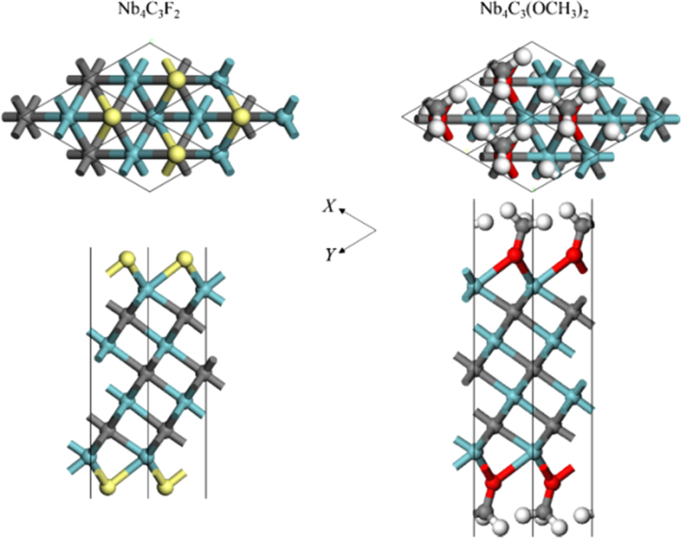
Top views and side views from the X direction of the optimal structures of Nb4C3F2 and Nb4C3(OCH3)2. The atoms represented by different color balls are the same as in Fig. 2.